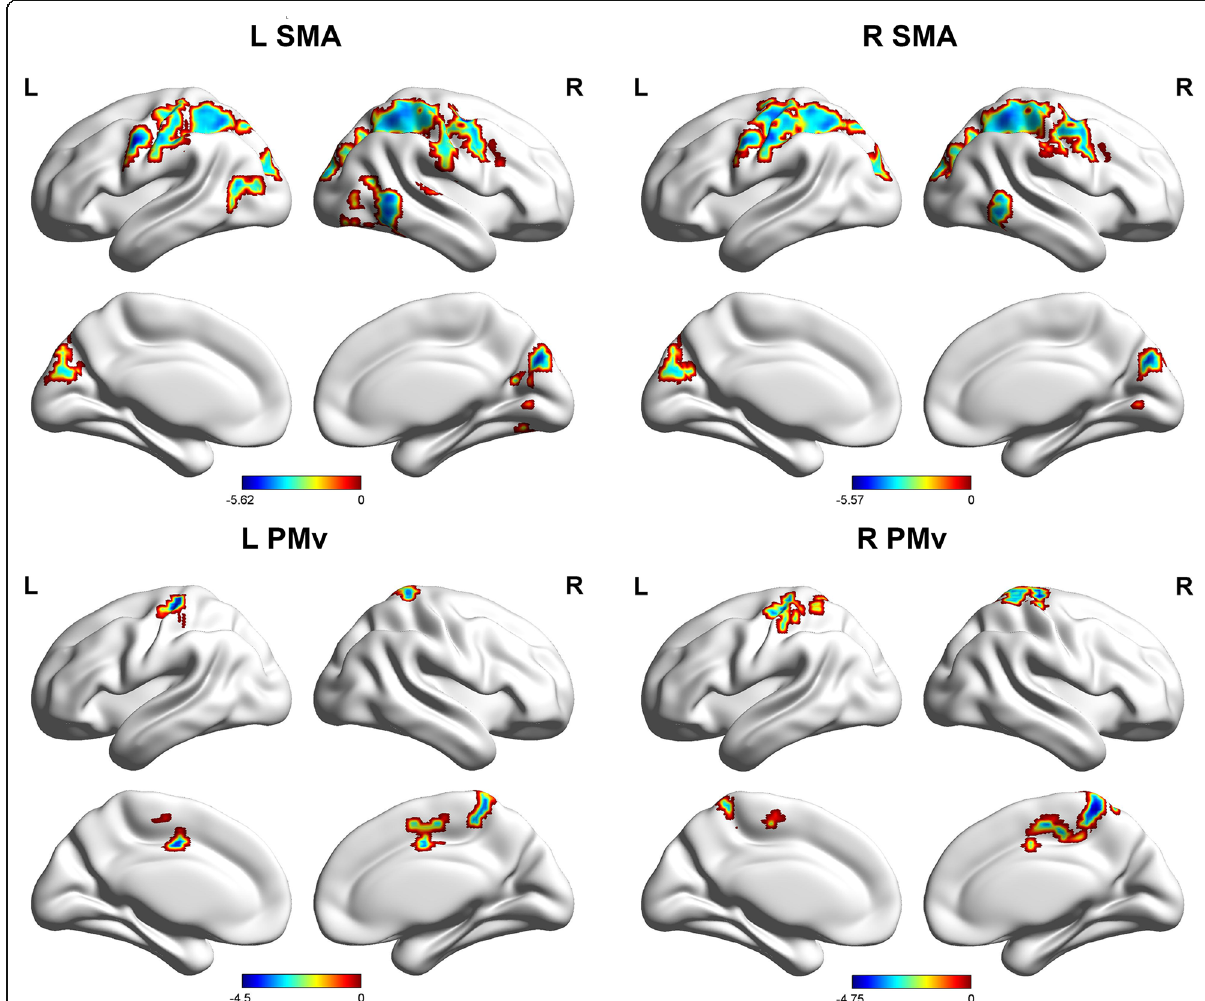
Fig. 2 Sagittal views of the MNI brain areas showing reduced intrinsic functional connectivity (FC) with the SMA and PMv in MWoAs compared to healthy controls. The surviving clusters were assigned thresholds at p < 0.001 (voxel level) and were FWE corrected to p < 0.05 at the cluster